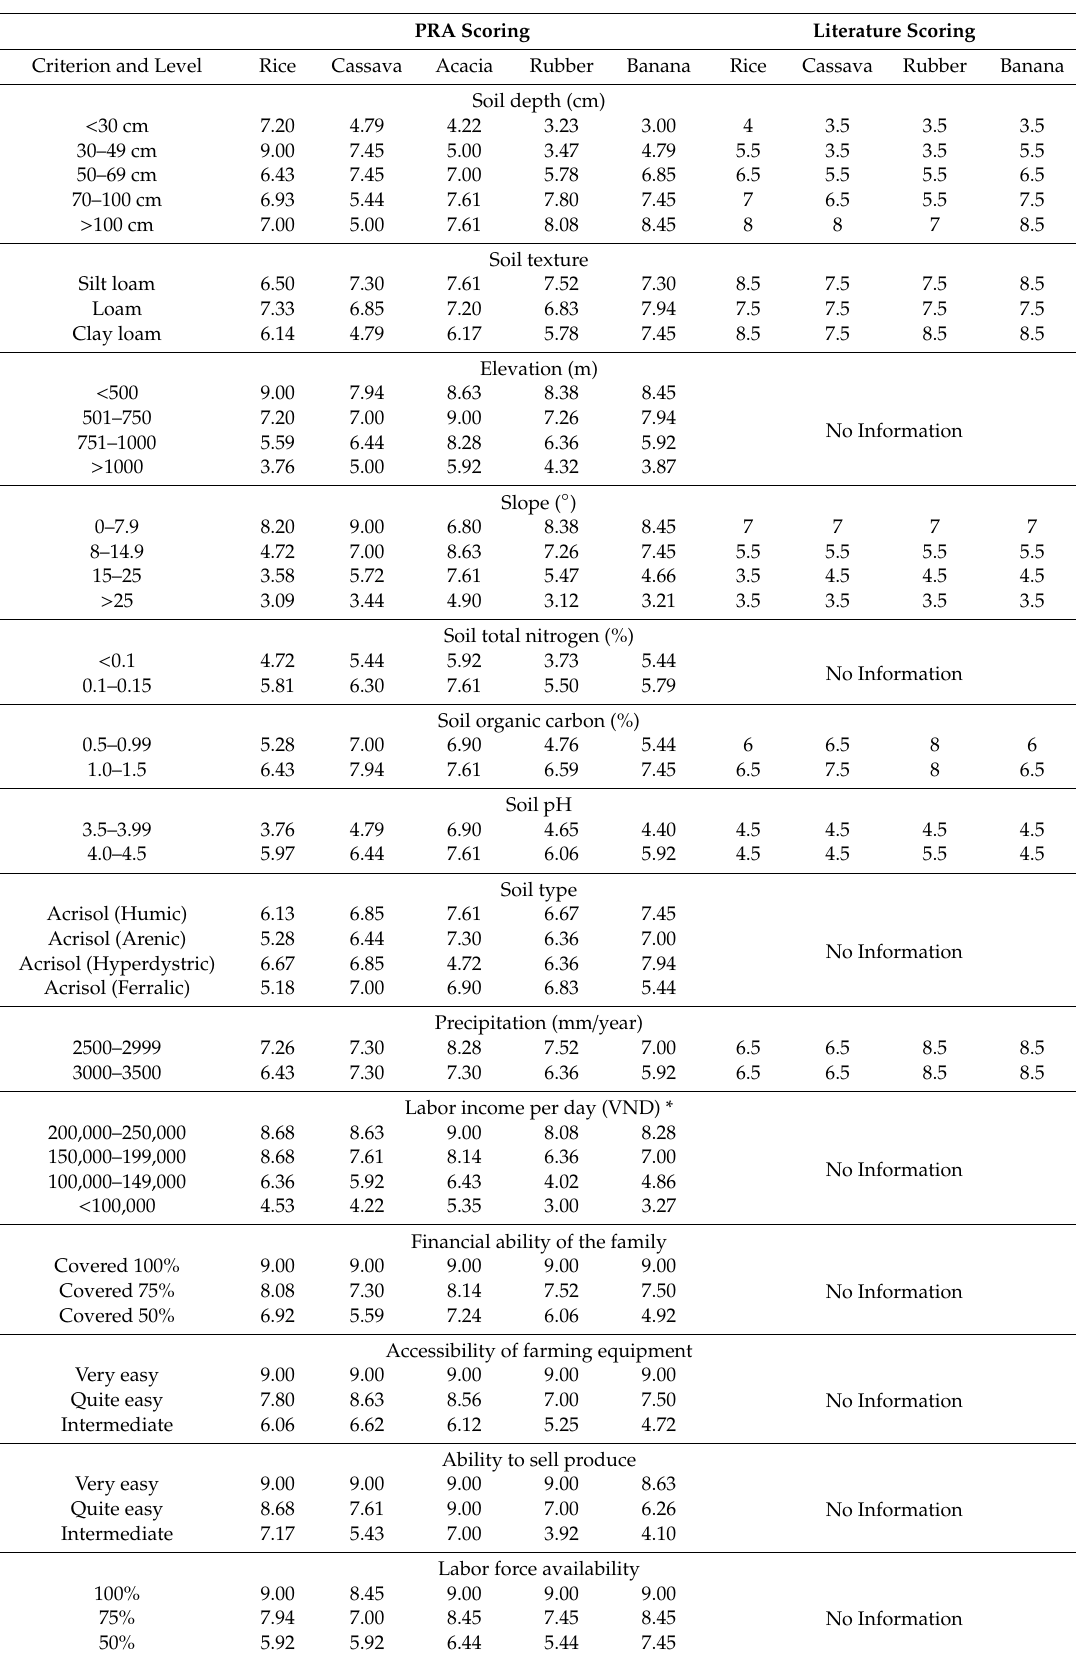
Table 9. Scores based on PRA and Literature scoring